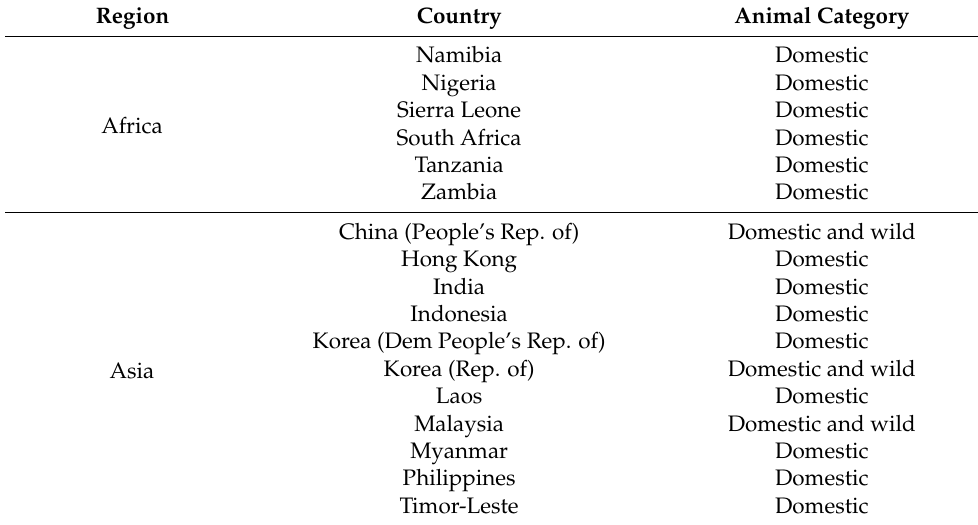
Table 1. Cases and outbreaks of ASF in 2021